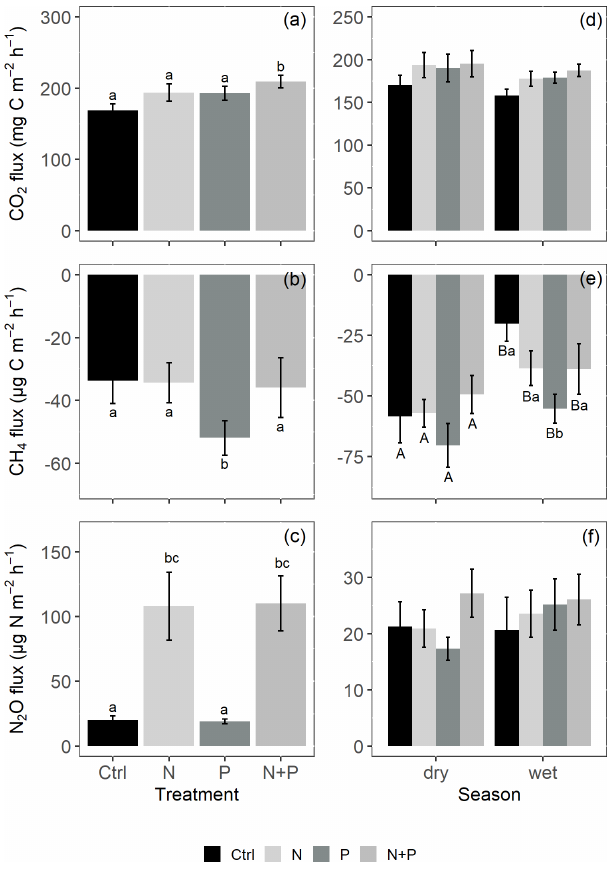
Figure 4. Mean ( ± SE; n = 4) soil CO 2 fluxes (a, d) , CH 4 fluxes (b, e) , and N 2 O fluxes (c, f) from the control (Ctrl), nitrogen (N), phosphorus (P), and N + P plots of the nutrient manipulation ex- periment. Column 1 (a–c) includes only fluxes measured during the transitory phase (0 to 28d after fertilization), and all the transitory fluxes were in the wet season (monthly precipitation > 100mm). Column 2 (d–f) includes only background-level fluxes (fluxes mea- sured more than 28d after fertilization). Different lowercase let- ters indicate significant differences between nutrient addition treat- ments and the control, while different uppercase letters indicate sig- nificant differences between seasons (linear mixed effects models; p ≤ 0 . 05). Note: transitory N 2 O fluxes (measured within 28d from fertilization) from N addition plots (N and N + P) were detrended to compensate for absence of frequent measurements immediately after fertilization coming from sampling GHGs